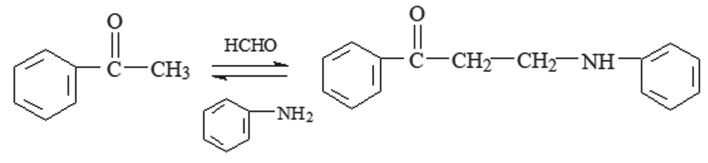
Synthetic of PPAPO.